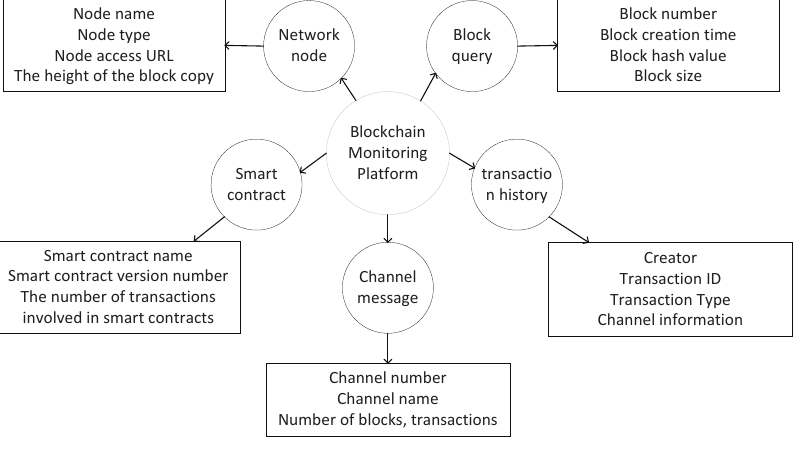
Figure 3. Blockchain operation monitoring